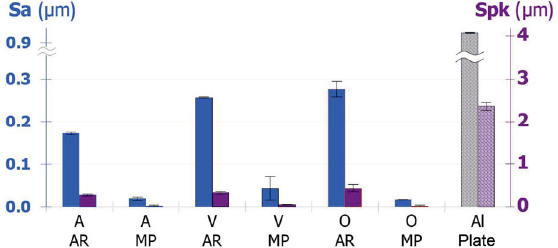
Fig. 3 Average areal roughness parameters of the different samples (ISO 25178, λ c = 0.25 μ m).